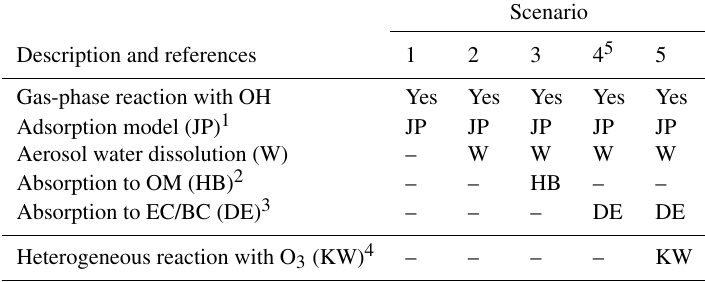
Table 2. Summary of the simulated scenarios designed to test gas-particle partitioning and heterogeneous reactivity of